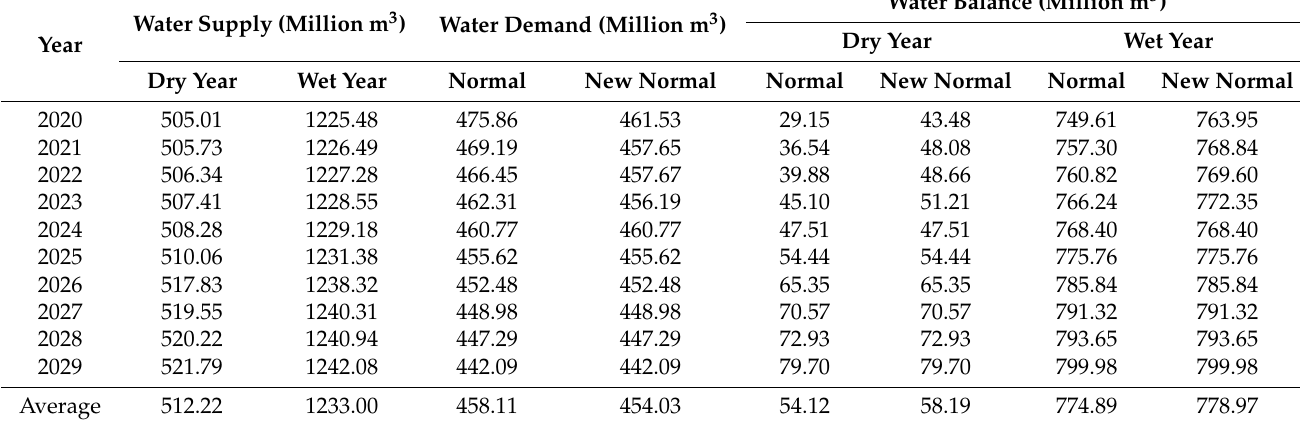
Table 24. The annual water supply and demand balance evaluation without considering ecological water requirements between 2020 and 2029.